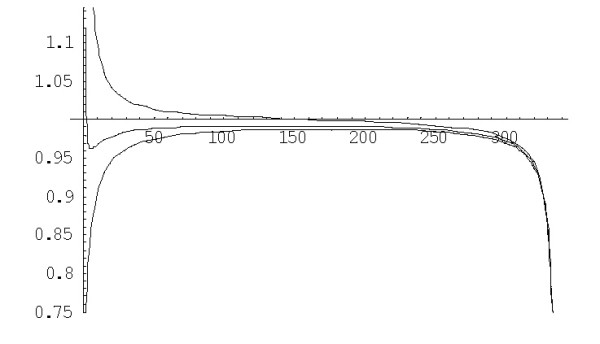
The ratio β i/μ i against family size i for the logistic BDIM (3.2) with c = 1 depending on the model degree d:d = 1, d = 1.6, d = 2 (from bottom to top). The model parameters are for Drosophila melanogaster